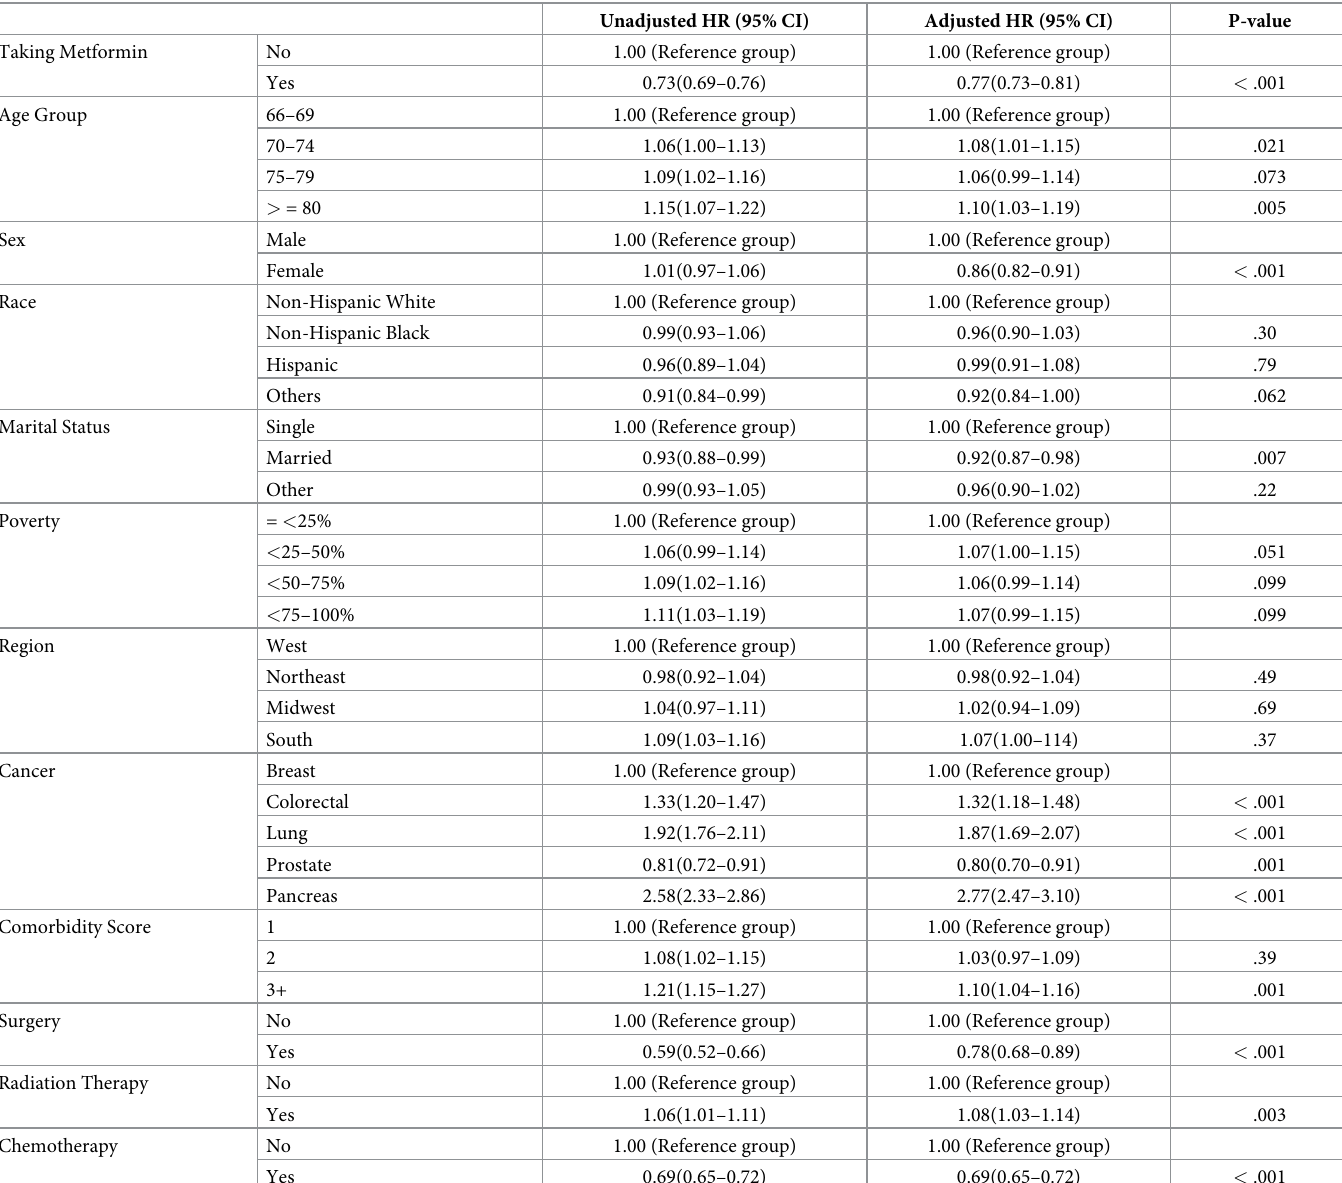
Table 2. Multivariable-adjusted hazard ratios of overall survival between individuals taking metformin and those who didn’t take